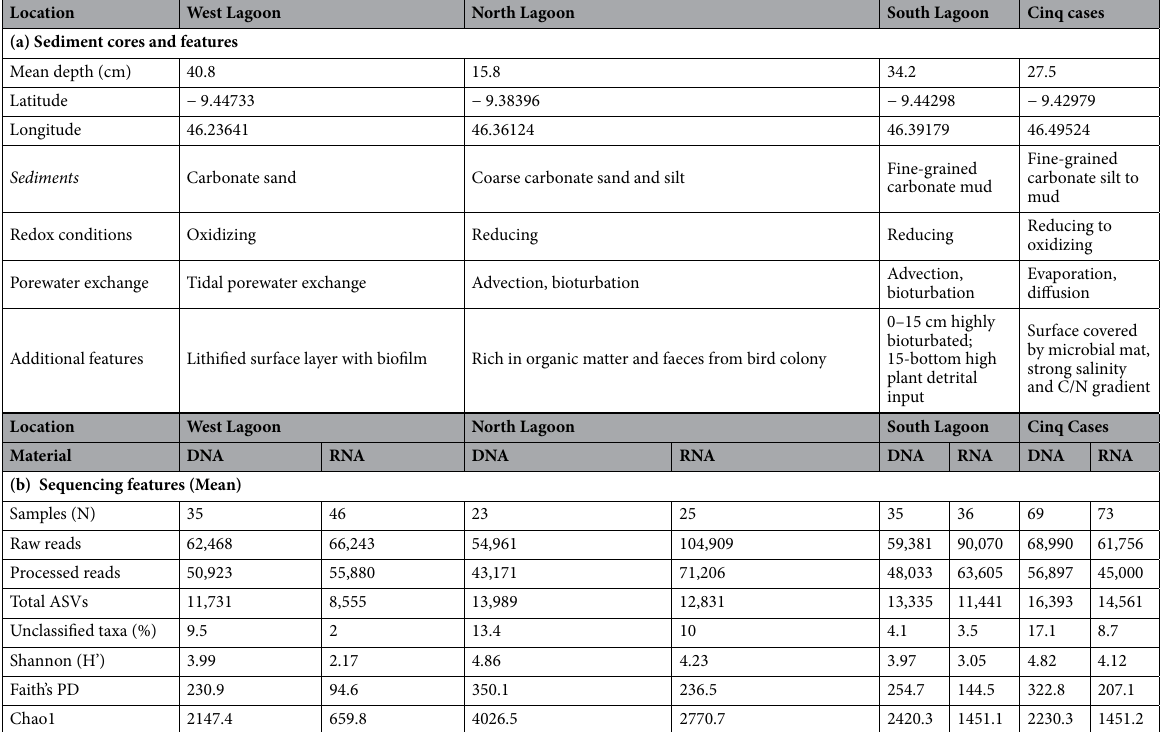
Table 1. Sediment characteristics (a) and sequencing features (b) of all sampling sites. (a) The main environmental characteristics for each sampling site, including sediment type and depth, redox conditions, and mode of porewater exchange. (b) total sample number and ASV counts, mean percentage of unclassified taxa and average diversity indices between the sampling sites and community fractions. Data were rarefied at 19,906 reads per sample for calculation of diversity indices. The phylogenetic diversity is based on a midpoint-rooted phylogenetic